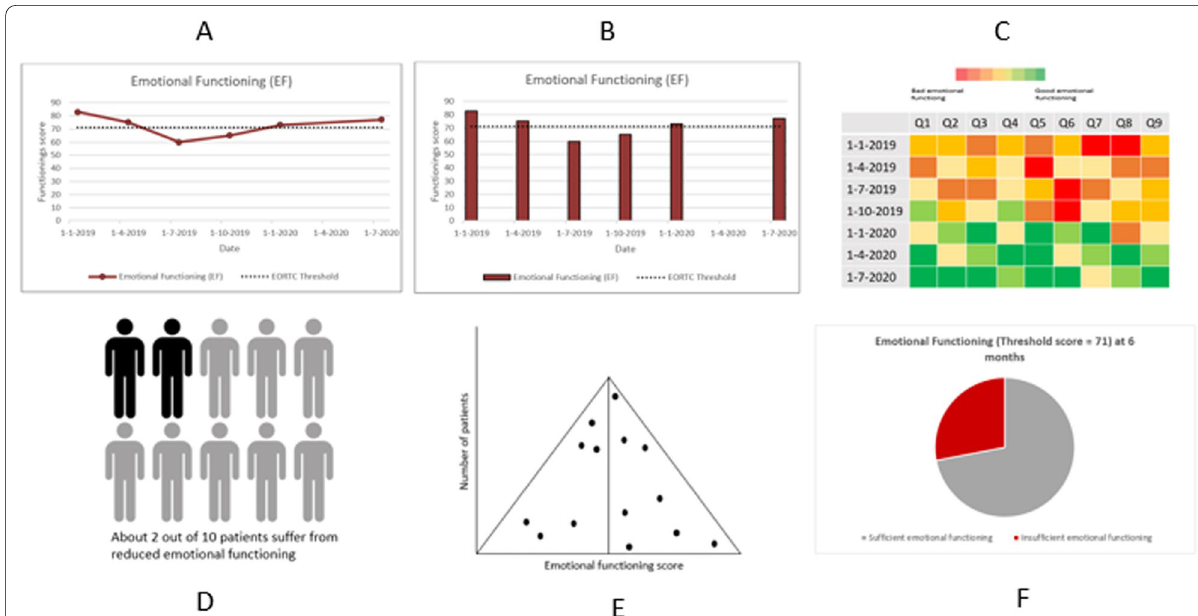
Fig. 3 Different graphic visualization formats, presenting the domain of ‘emotional functioning’ as an example. Longitudinal: a line graph, including threshold line; b bar chart, including threshold line; c heat map. Cross‑sectional: d icon array; e funnel plot; f pie